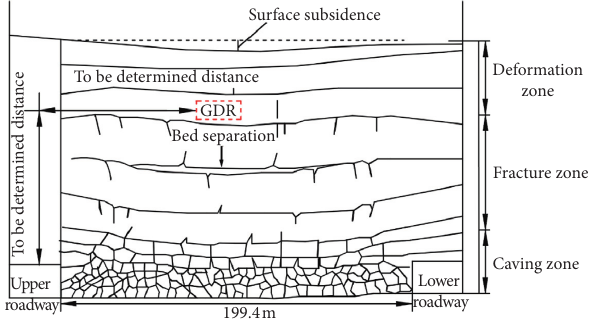
Figure 2: Distribution of working